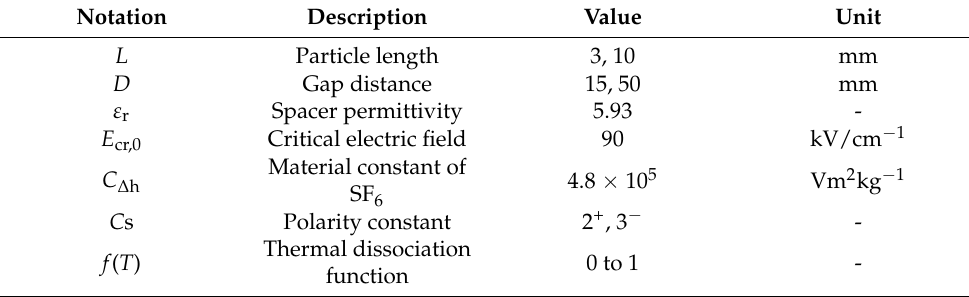
Table 1. Notations used in the